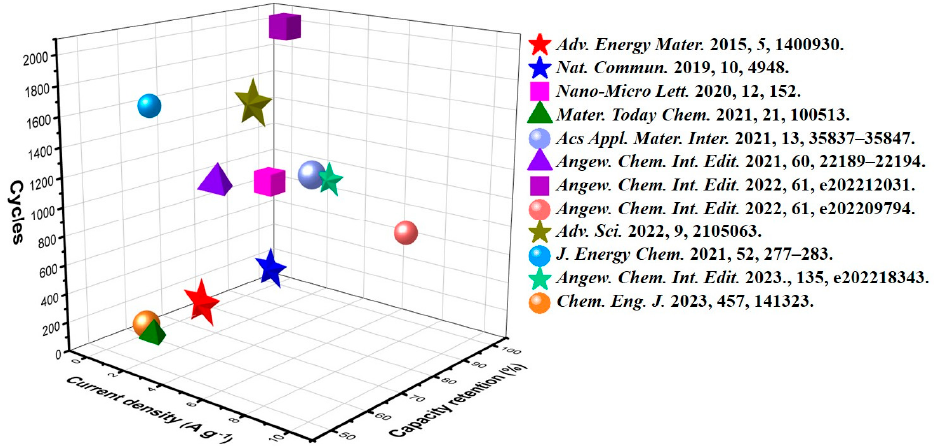
Figure 6. Comparison of cycle stability obtained in works [42,49–56,65,69,73] reviewed above.